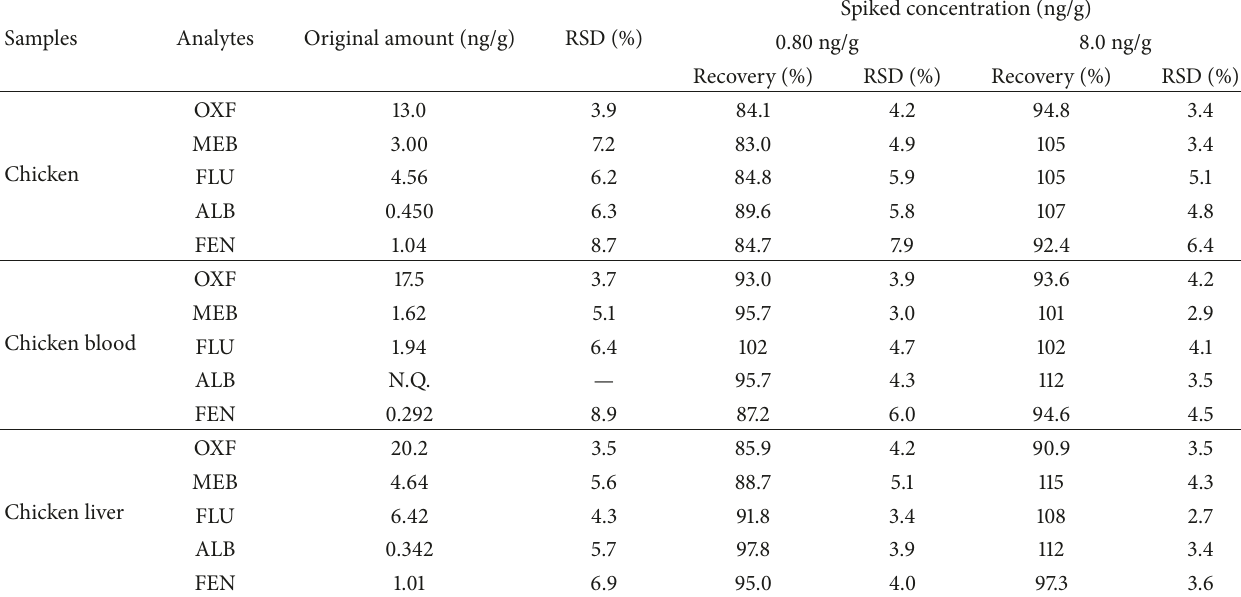
Table 2: Analysis of BMZs in food samples using the magnetic solid-phase extraction coupled to HPLC (𝑛 = 5) .